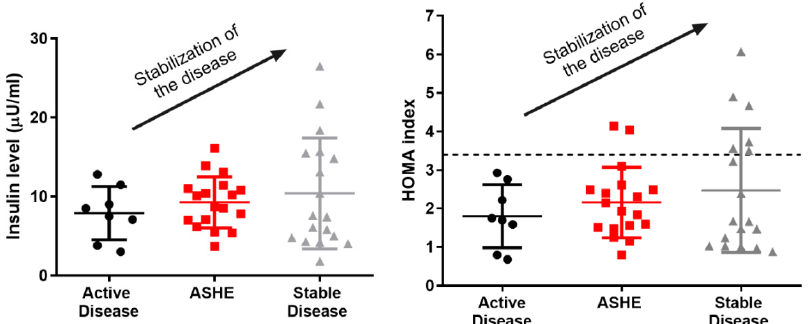
Figure 2. Plasma insulin quantification and HOMA index in porphyric patients. It is clear that, as the insulinemia and the HOMA of the patients rise, their disease stabilizes. AD: active disease, ASHE: asymptomatic high excreters, HOMA: homeostasis model assessment, SD: stable disease.